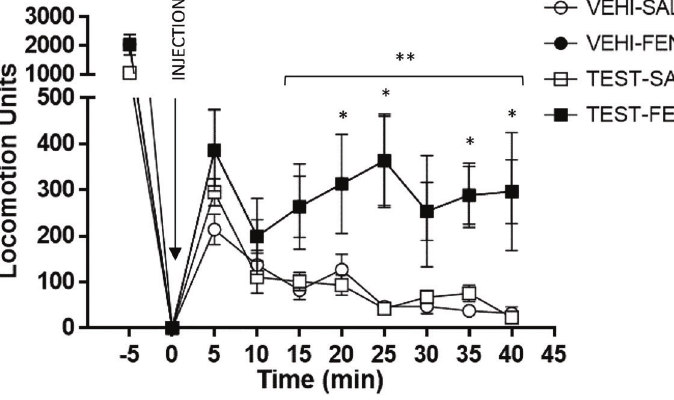
Figure 1. Locomotor activity following fenpro- porex (3 mg/kg, ip ) challenge in adolescent rats (post-natal day, PND 41, n=35) pretreated with repeated testosterone injections (10 mg/kg, sc ) from PND 28 to PND 37. Locomotor activity was measured during 40 min. Data are reported as means ± SE. -5 min: habituation. *P o 0.05: vehi- cle-fenproporex (VEHI-FENP) signi fi cantly differ- ent from vehicle-saline (VEHI-SAL). **P o 0.05: testosterone-fenproporex (TEST-FENP) signi fi - cantly different from testosterone-saline (TEST- SAL). ***P o 0.05: TEST-FENP signi fi cantly different from VEHI-FENP (three - way ANOVA followed by Newman-Keuls ’